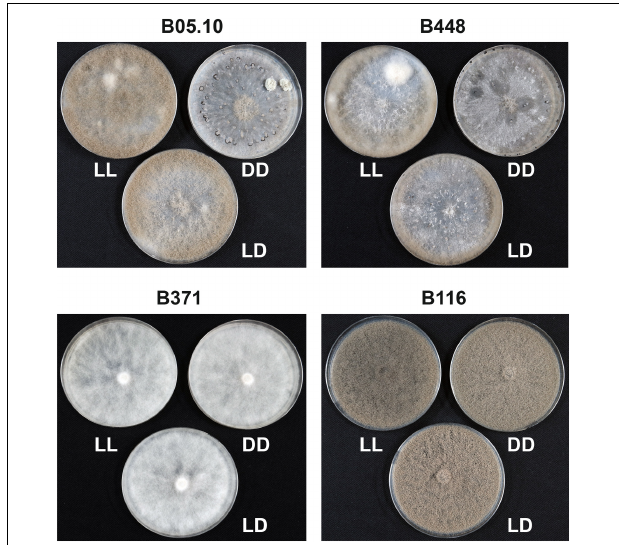
FIGURE 2 | Evaluation of the effect of light on sporulation and sclerotia production in the non-pathogenic natural mutants identified in comparison with the aggressive field isolate B448 and the reference isolate B05.10. Isolates were grown for 14 days in permanent light (LL), constant darkness (DD) or a 16 h photoperiod